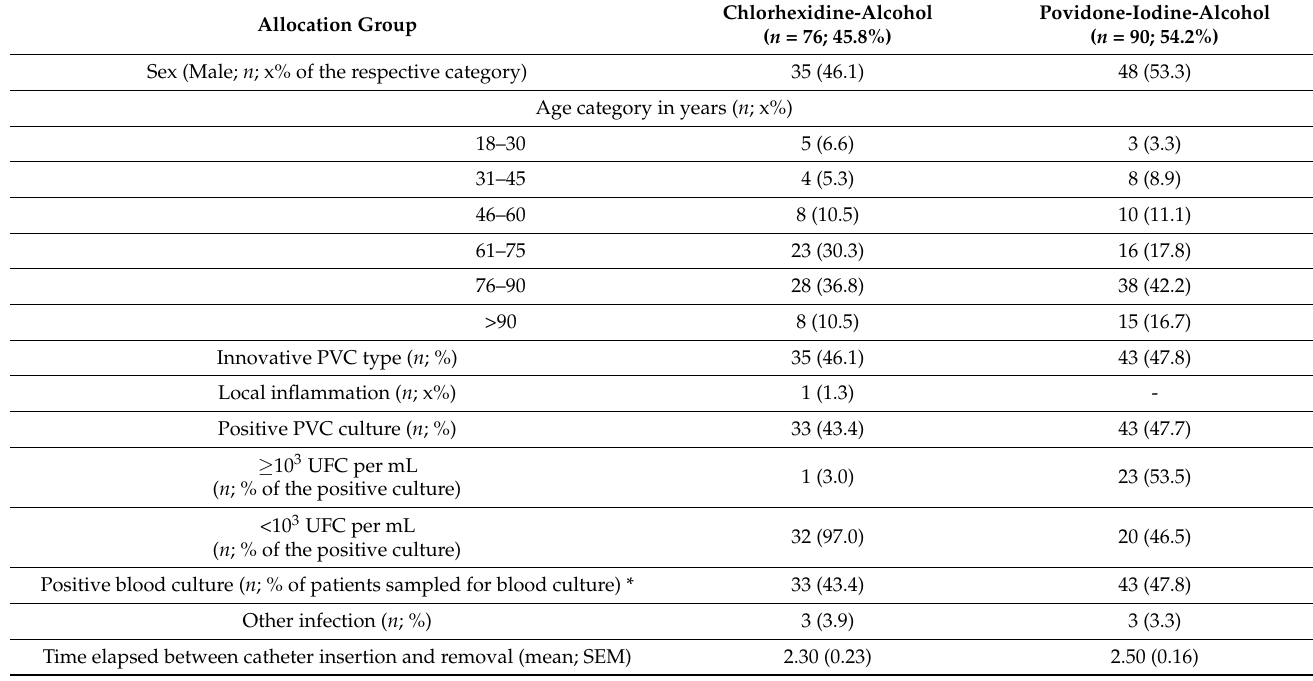
Table 1. Characteristics of the included patients according to their randomization